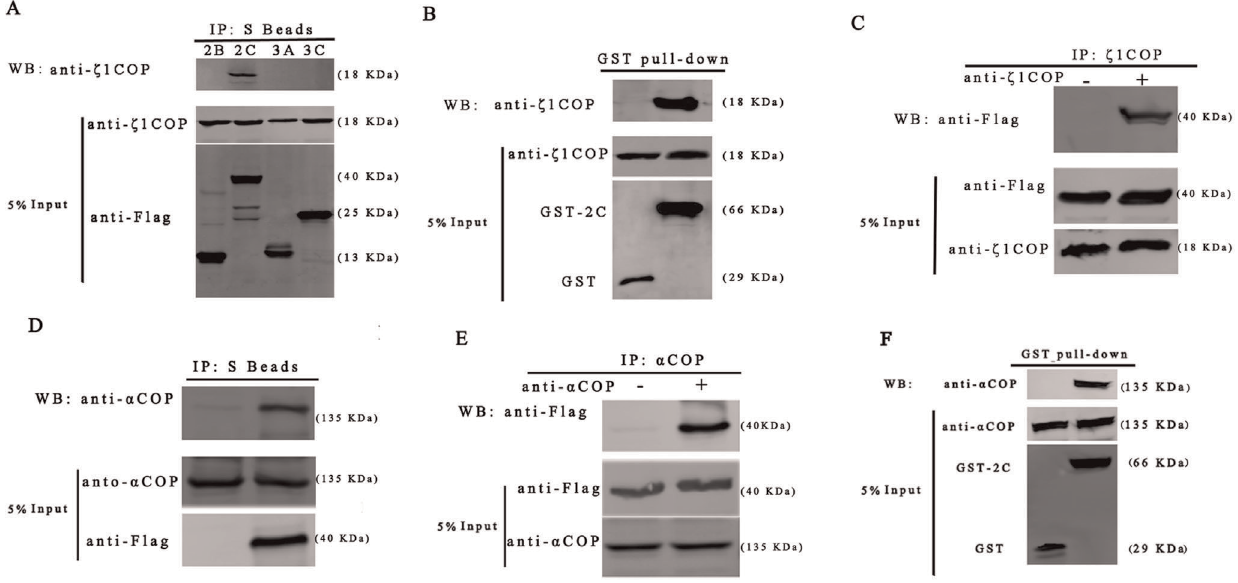
Figure 6. COPI interact with viral protein 2C. (A) At 24 hpt, immunoprecipitation was conducted with S beads and western blotting was carried out as indicated. (B) GST pull-down was performed with 293T cell lysates. Western blotting detection was carried with indicated antibodies. (C) Immunoprecipitation was conducted with Protein A agarose plus anti- f 1COP antibody and western blotting was carried out as indicated. (D) Immunoprecipitation was conducted with S beads and western blotting was carried out as indicated. (E) Immunoprecipitation was conducted with Protein A agarose plus anti- a COP antibody and western blotting was carried out as indicated.